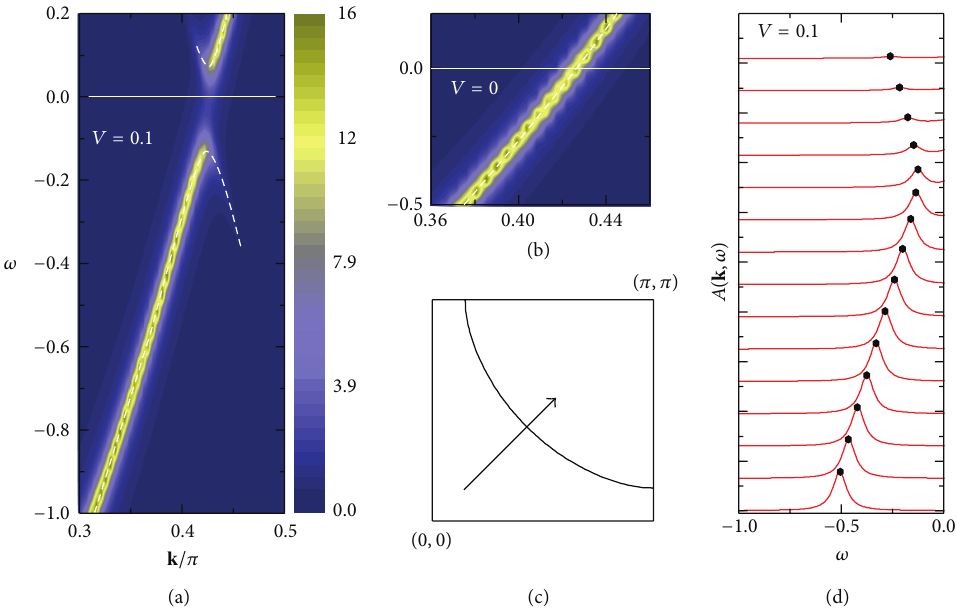
Figure 1: ((a)-(b)) Intensity plots of the spectral function with and without the ID-SDW order, respectively. (c) The normal state Fermi surface. The arrow indicates the cut along which (a), (b), and (d) were taken. (d) The energy dependence of the spectral function along the arrow in (c) (from bottom to